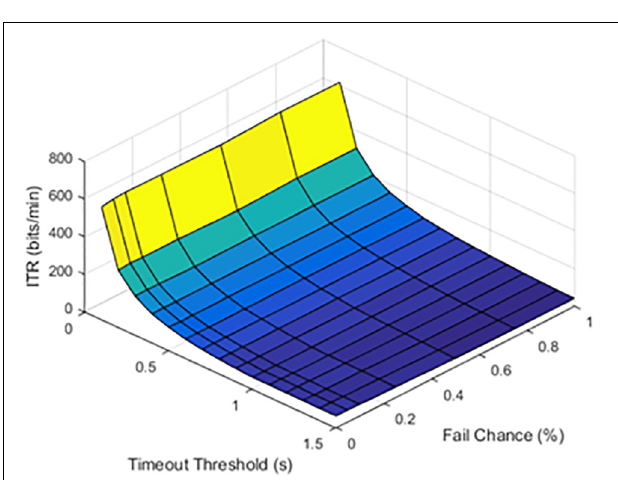
FIGURE 2 | Information transfer rate (ITR) values at a 25% stimulation failure rate (SFR). The results show where stimulation command would fail 25% of the time.